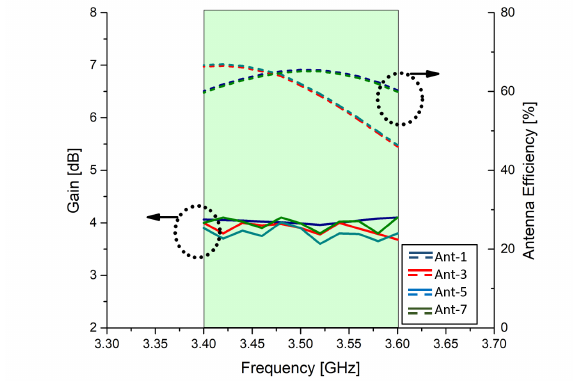
Figure 6. Total efficiency and maximum gain over frequency of MIMO antenna system.